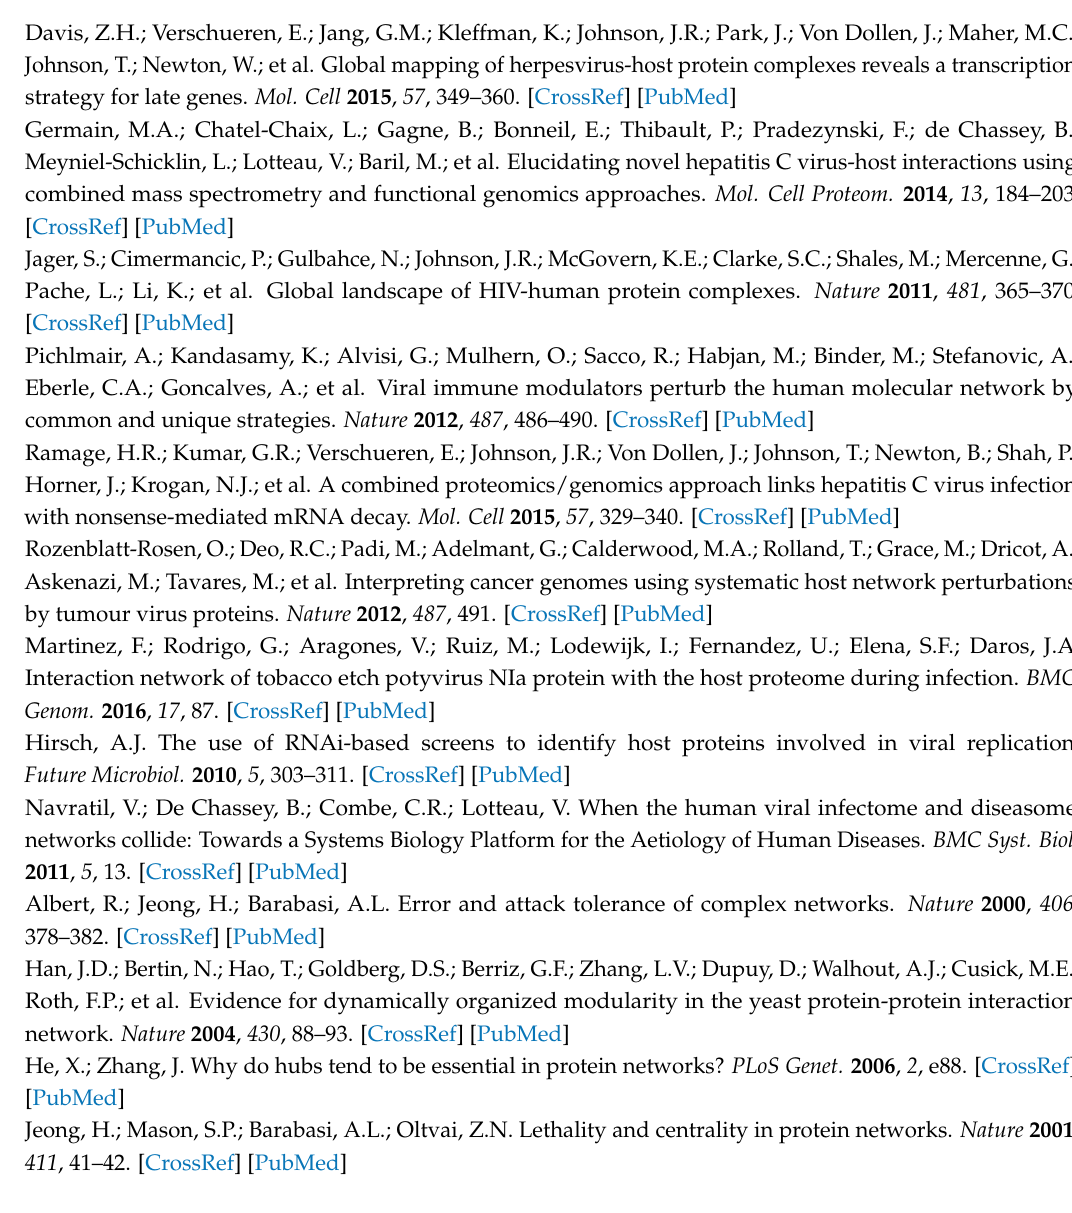
Table S2: Arabidopsis best-hits of the N. benthamiana interactors of TYLCV proteins and their described interactors in the Arabidopsis proteome; Table S3: Functional enrichment analysis of the N. benthamiana interactors of TYLCV proteins (list of enriched GO terms and the corresponding genes—Biological Process, Molecular Function, and Cellular Component Ontologies); Table S4: Primers used in this